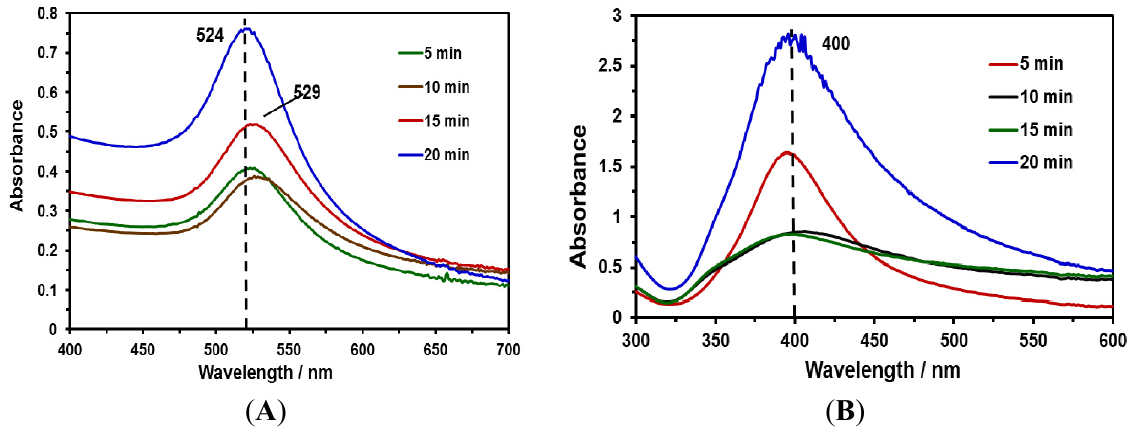
Figure 1. UV-Vis absorption spectra of Au and Ag nanoparticles (NPs) at